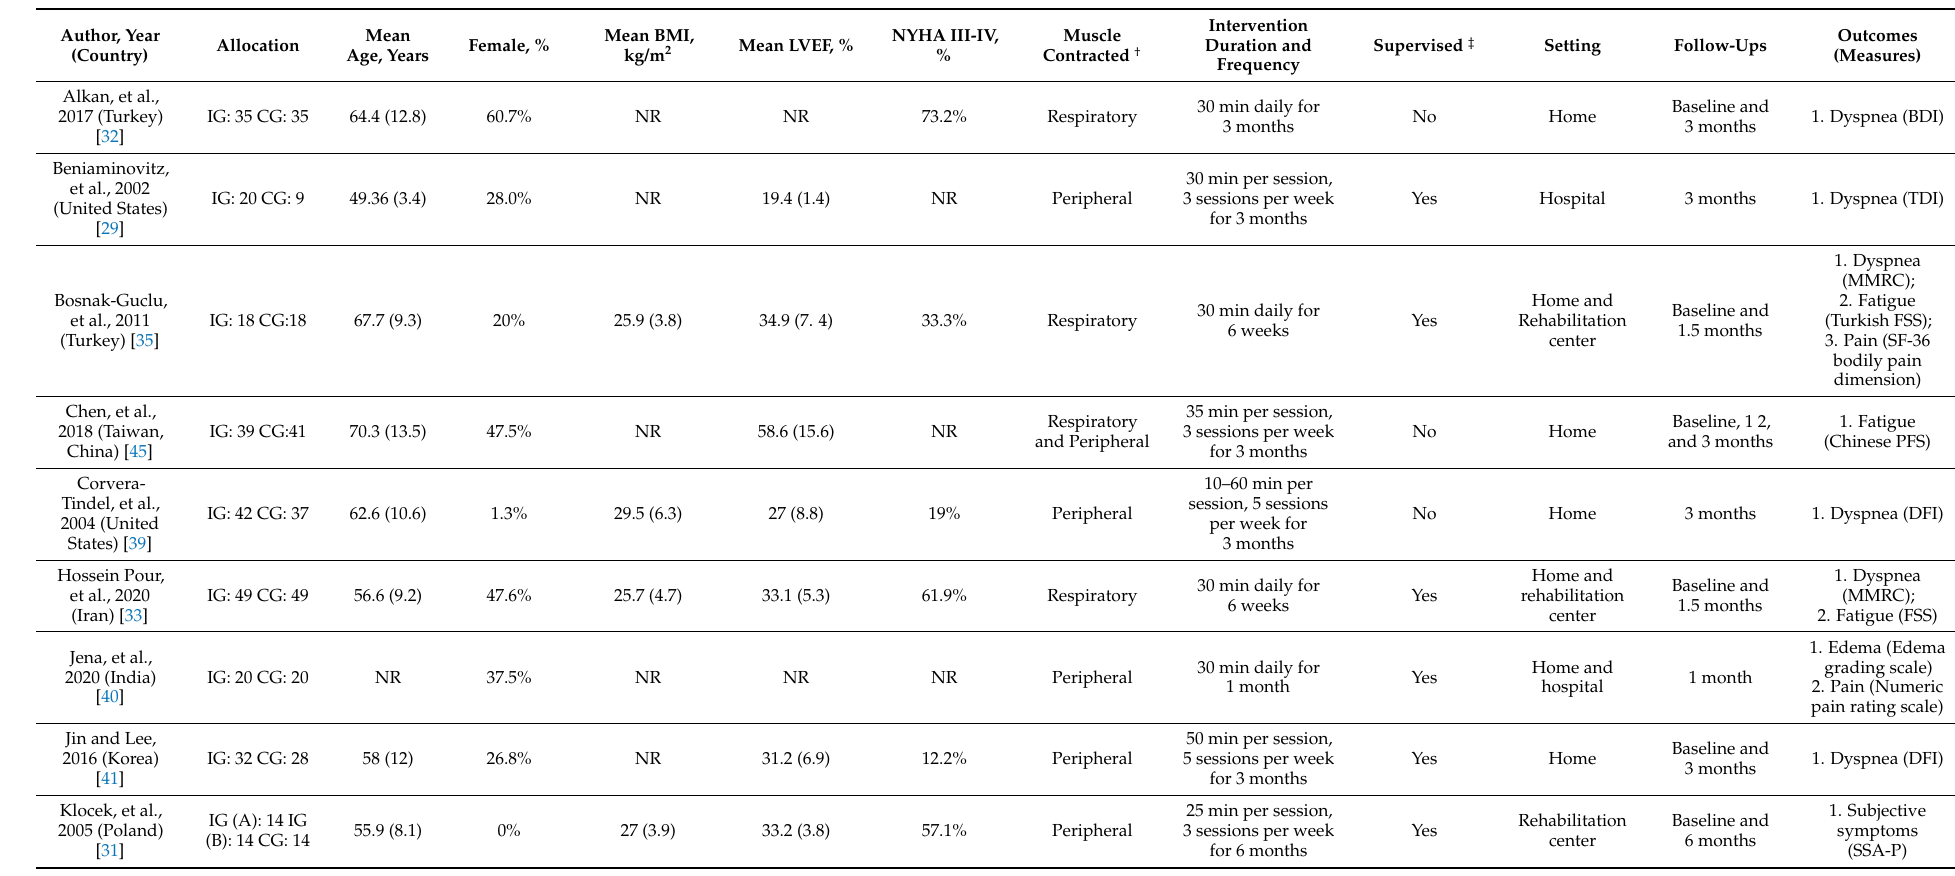
Table 1. Basic information of included